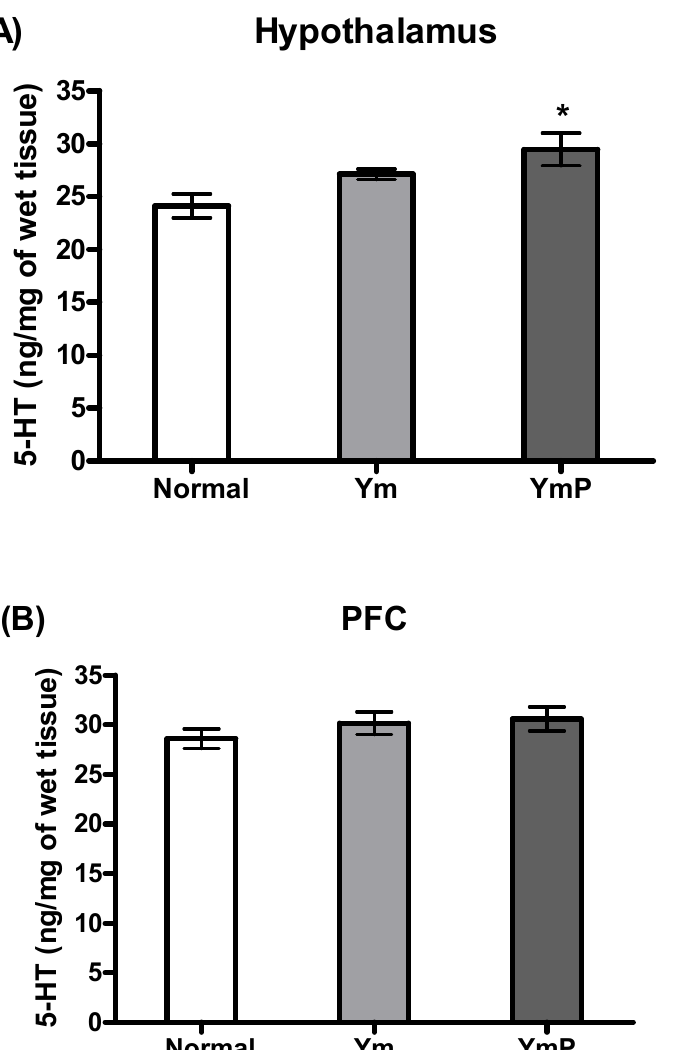
Figure 4. The effect of YmP on 5-HT concentration. Mean ( ± SEM) 5-HT level of the hypothalamus ( A ) and PFC ( B ) in the Ym and YmP treated groups. * p < 0.05 vs. Normal (saline-treated group); one-way ANOVA followed by Tukey HSD. Yukmijihwang-tang (Ym); modified Yukmijihwang-tang (YmP); prefrontal cortex (PFC).